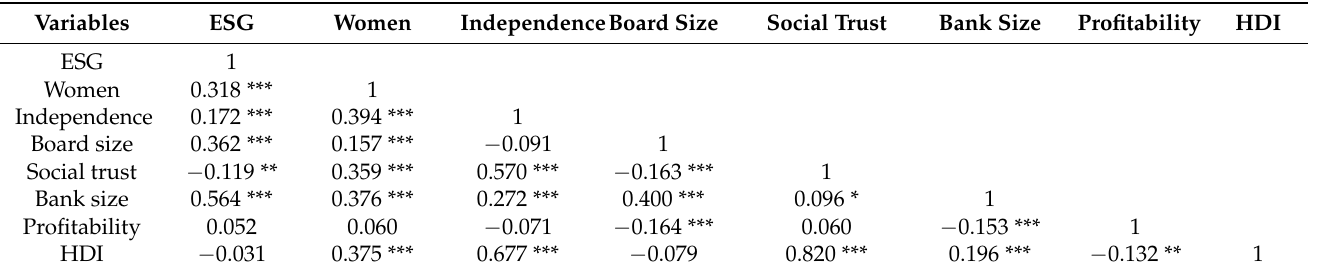
Table 4. Correlation matrix.